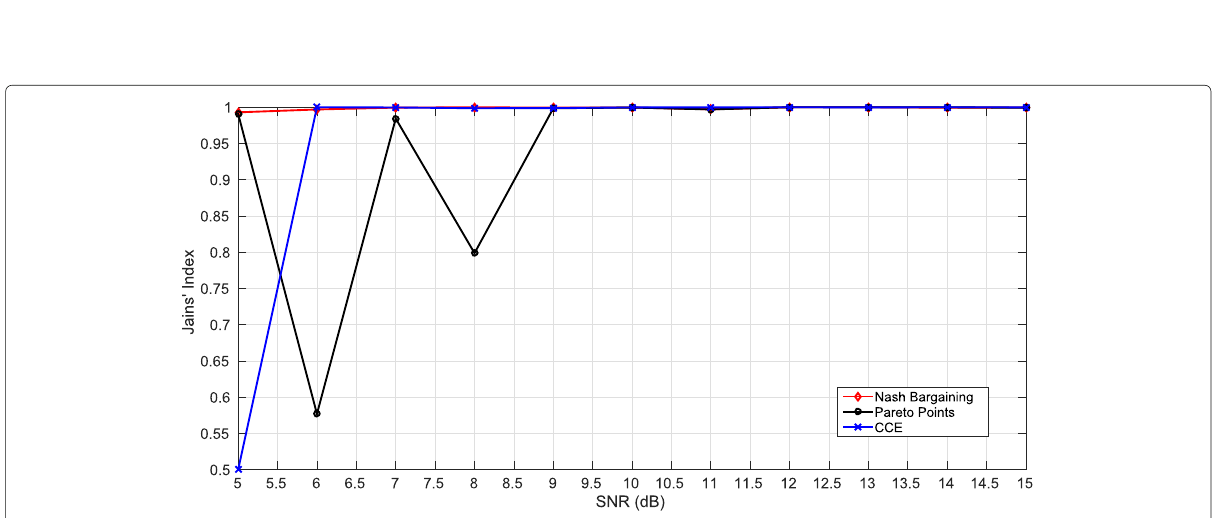
Fig. 7 Fairness of CCE, PP and NBS at fixed transmission rate (with CSI of